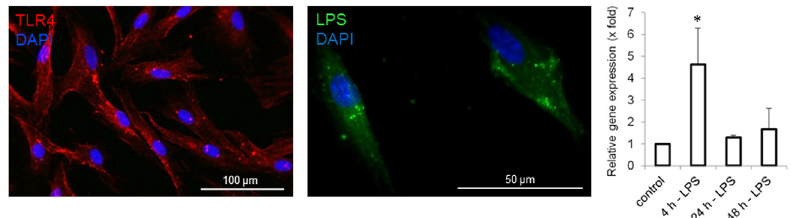
Fig 1. LPS Uptake. An immunocytochemical staining revealed the expression of TLR4 in skin-derived stem cells (SDSC). The incorporation of LPS could be shown by staining of LPS in SDSC. The LPS uptake led to a significantly enhanced expression of TLR4 mRNA 4 hours after stimulation with 10ng/ml LPS. Afterwards TLR4 expression returned to normal level. * p <